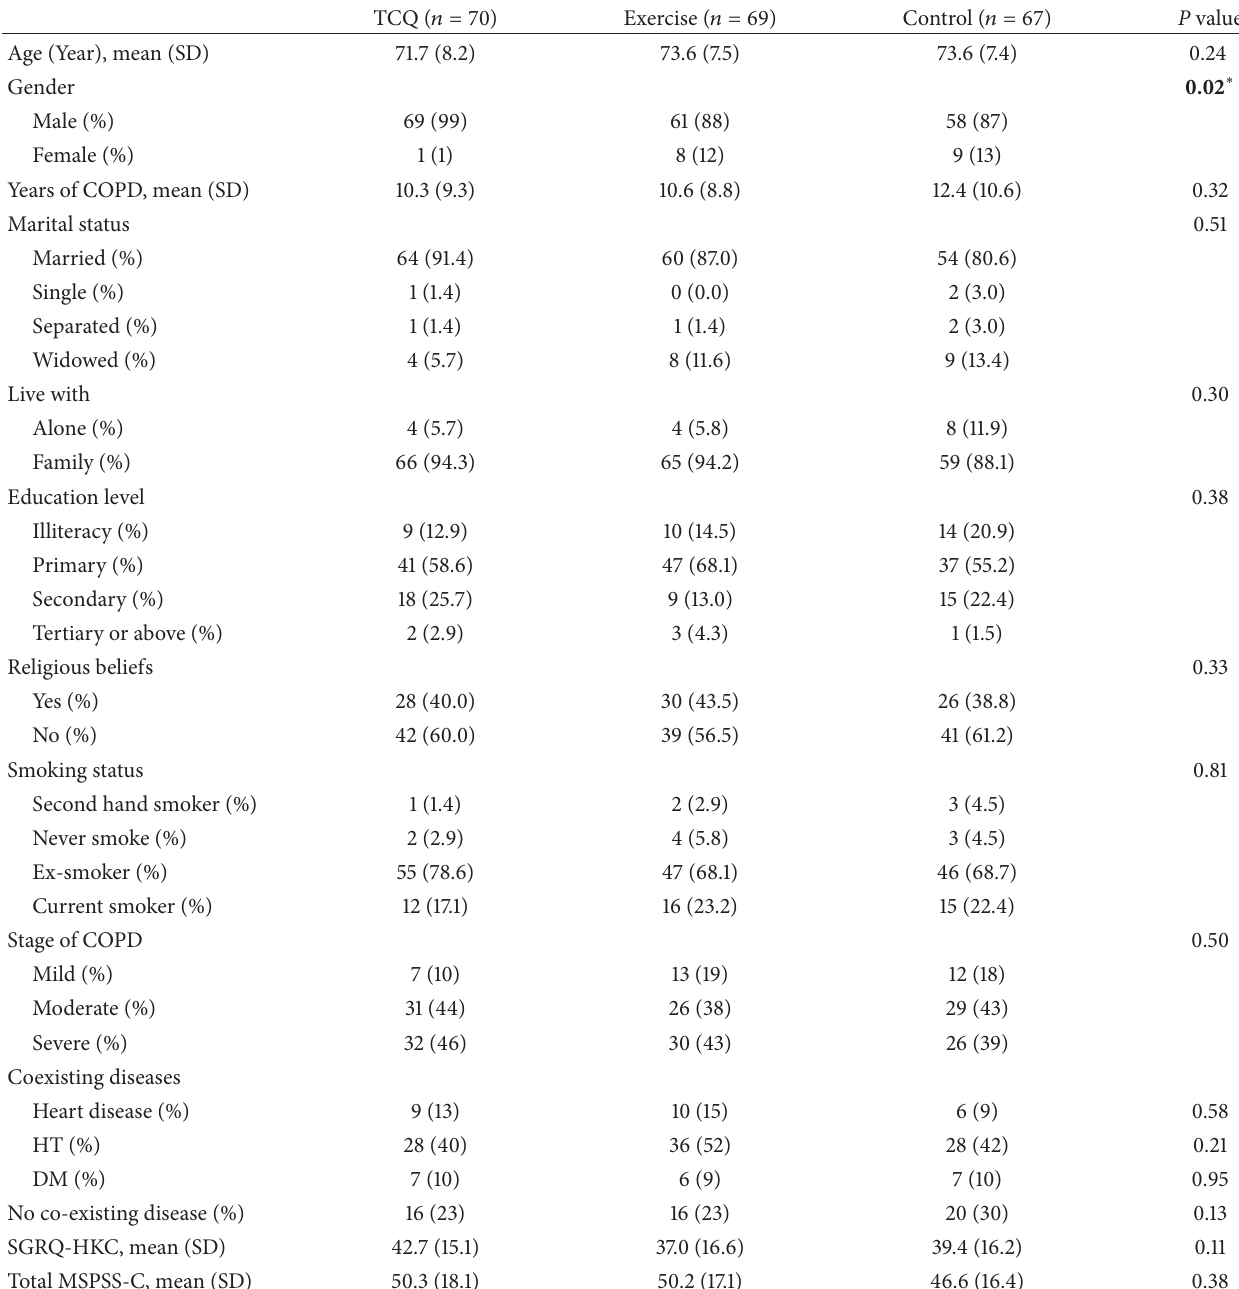
Table 1: Demographic and baseline data of subjects by group allocation [11] ∗